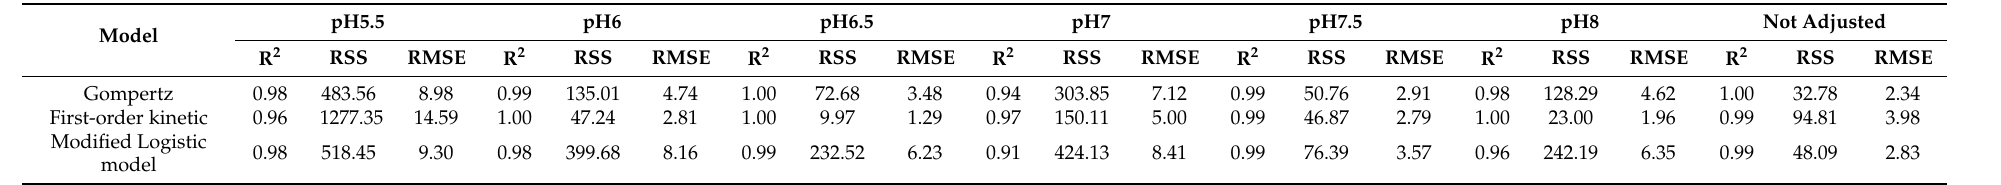
Table 5. Statistical analysis of the three compared models describing H 2 production with seven different initial pH